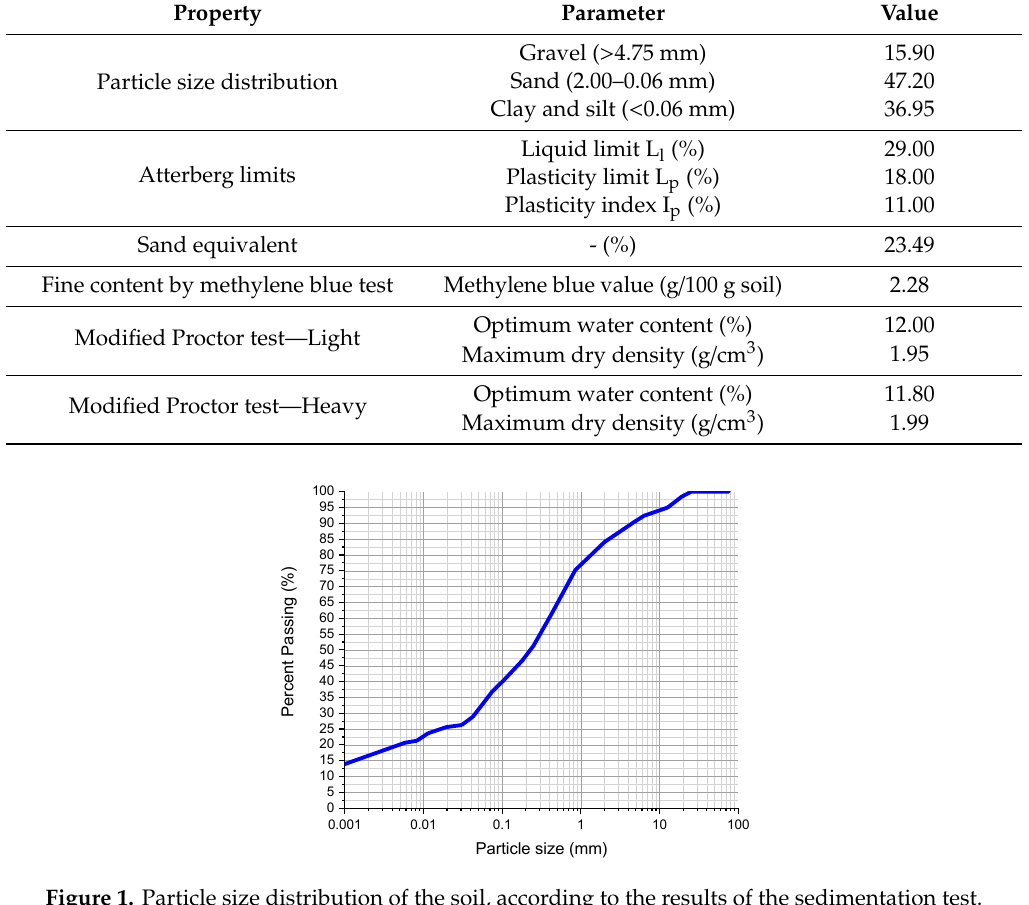
( b ) Figure 2. Electric resistivity test: measurements were done in two samples faces—( a ) width and ( b ) length.